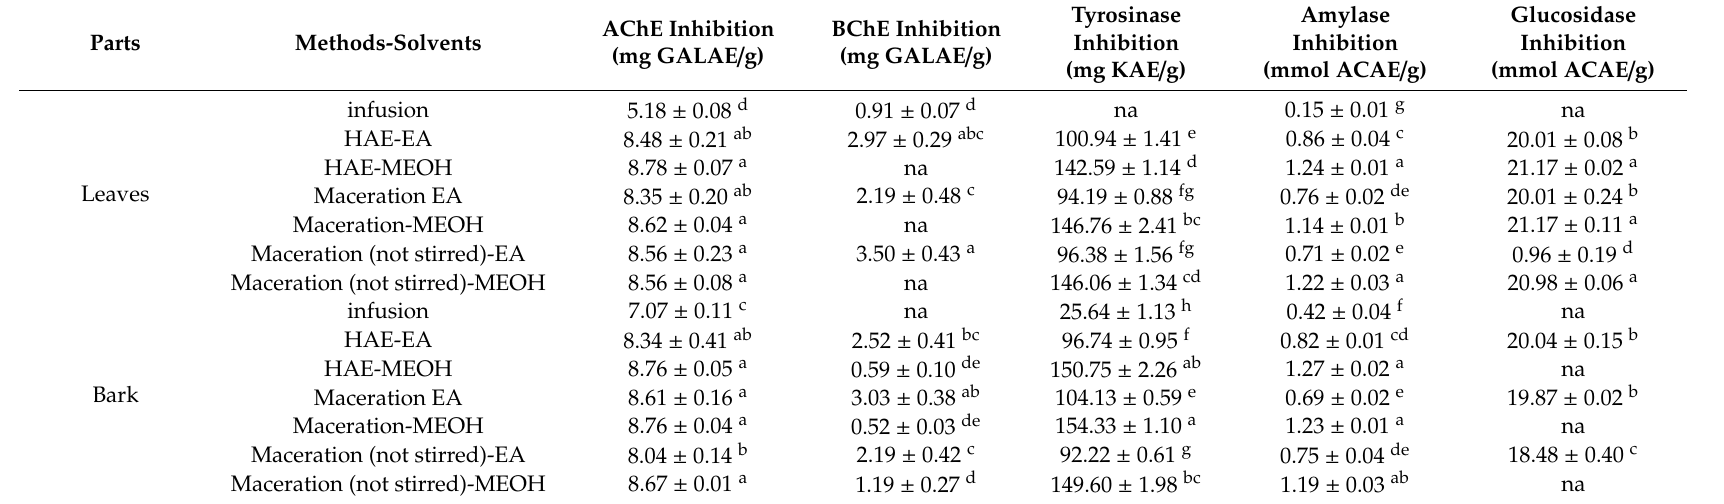
Table 4. Enzyme inhibitory e ff ects of the tested extracts